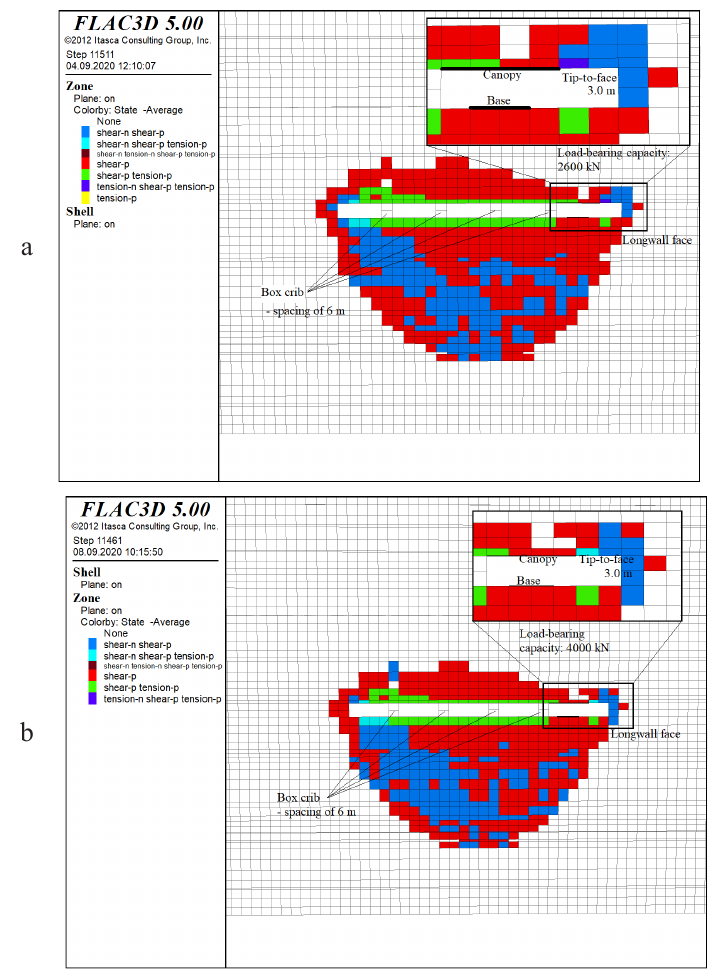
Figure 21: Plasticity around the longwall face with different load-bearing capacities of the powered roof support: a) 2600 kN b) 4000